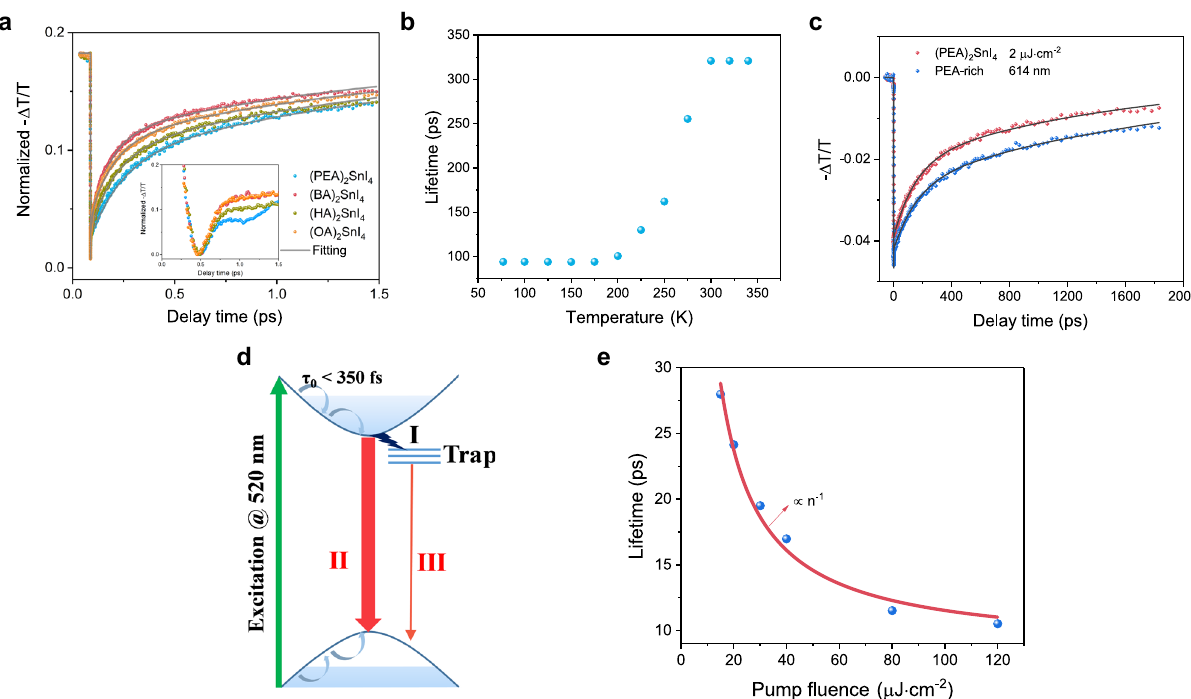
Fig. 6 The second component (II) of the exciton relaxation kinetics. a Normalized band-edge GSB relaxation process under the pump fl uence of 2 µ J cm − 2 for the (PEA) 2 SnI 4 , (BA) 2 SnI 4 , (HA) 2 SnI 4 , and (OA) 2 SnI 4 thin fi lms. The internal illustration shows the relaxation process of the four materials within 2ps. b Change in the lifetime of component II in the TA spectra of the (PEA) 2 SnI 4 sample with temperature. c Band-edge exciton relaxation process of (PEA) 2 SnI 4 (red represents) and PEAI-rich (blue represents) under the pump fl uence of 2 µ J cm − 2 . d Schematic diagram of the TA relaxation process with excitation at 520 nm. e Relationship between the lifetime (blue represents) of the Auger process and the pump fl uence; the red curve is the fi tting result of the two-body interaction theory of